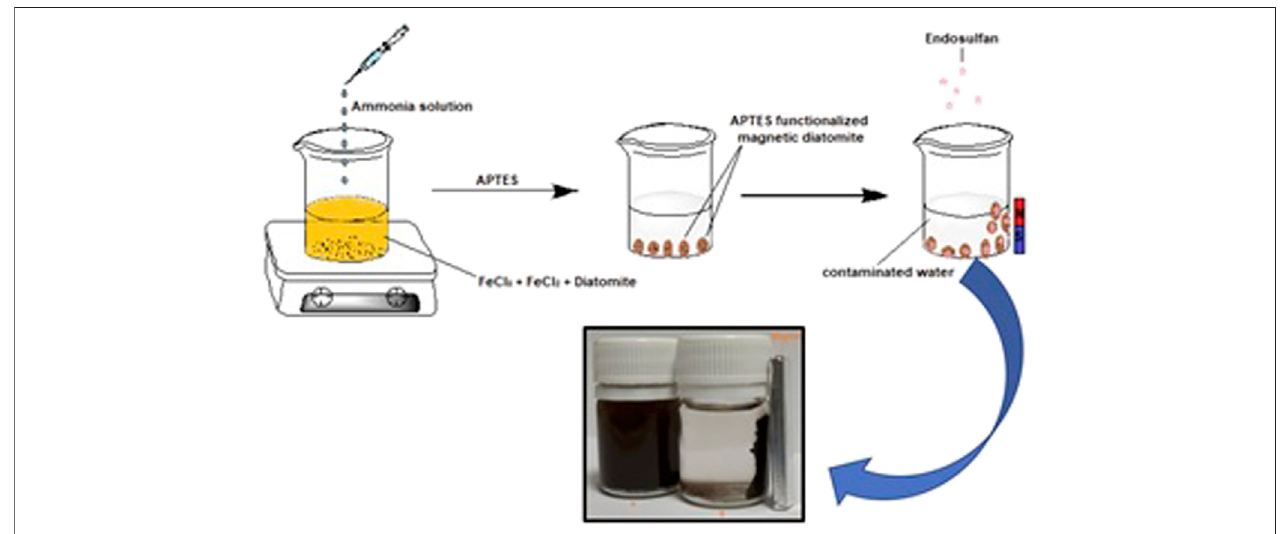
FIGURE 1 | Schematic presentation of the synthesis of m-DE-APTES.